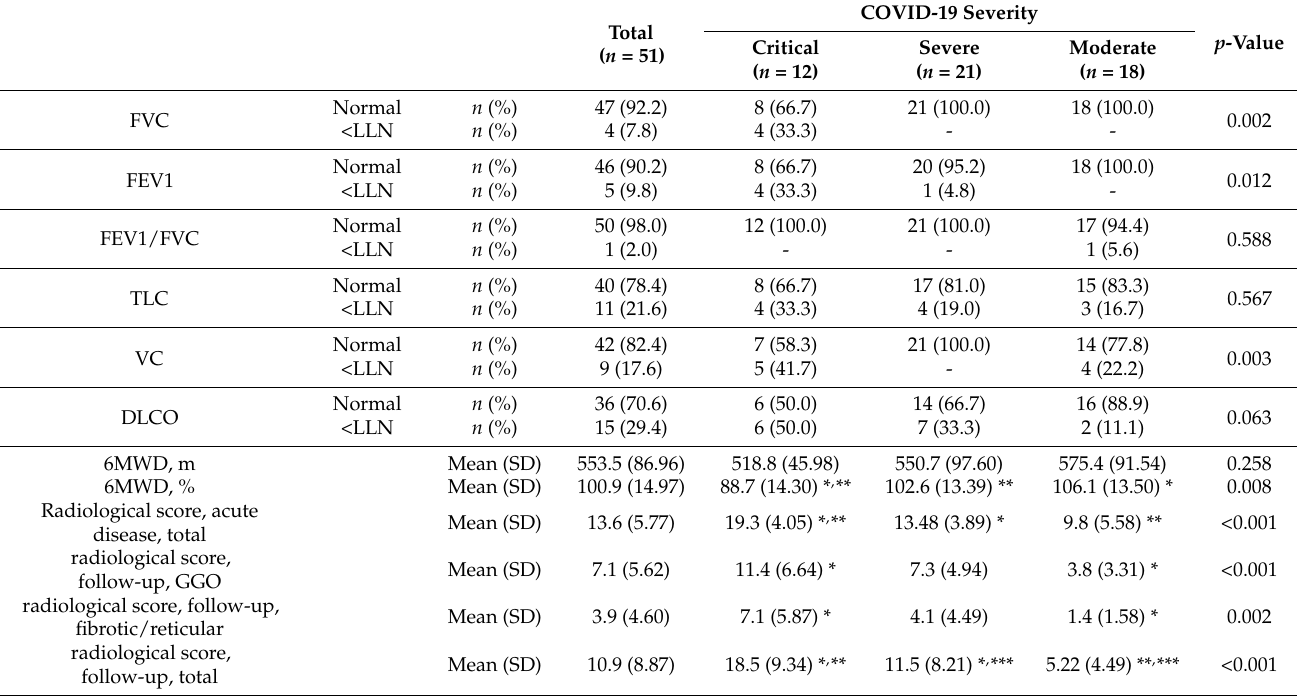
Table 2. Pulmonary function, physical capacity and radiological analysis at